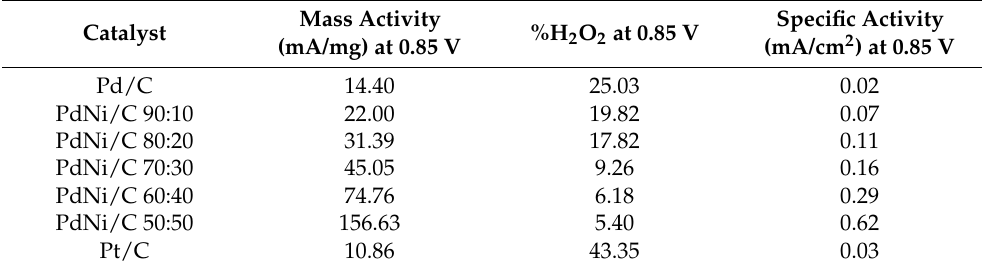
Table 3. ORR activities in Alkaline solutions for carbon-supported Pd, PdNi and Pt catalysts. Catalyst